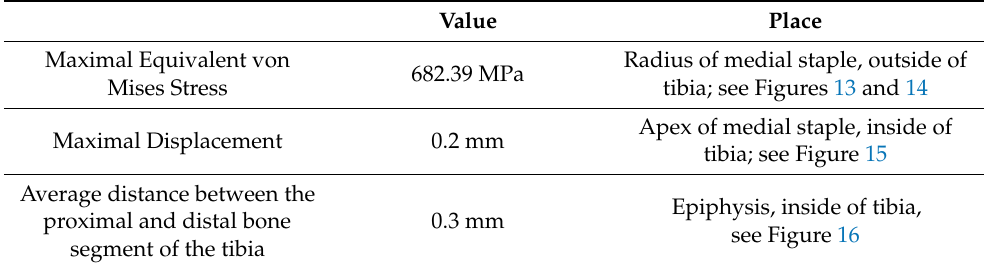
Figure 18. The model at the end of the experiment.